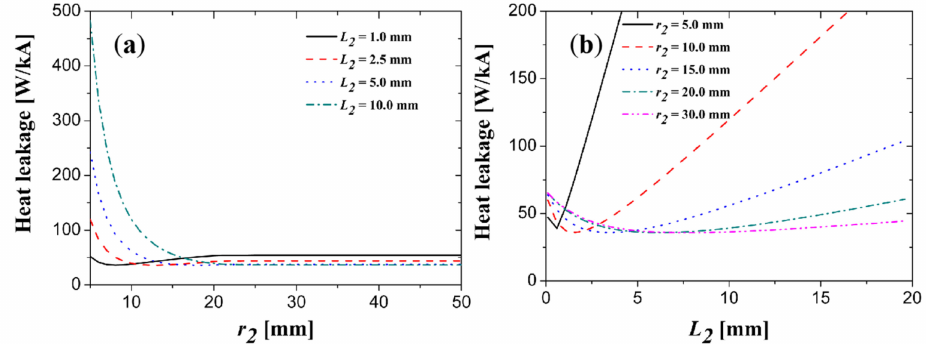
Figure A13. Iteration step one: the coupling influence between D ( r 2 ) and E ( L 2 ) on the cold end heat leakage of PCLs (keeping parameters r 1 = 20.0 mm, L 1 = 100.0 mm, L 3 = 1500.0 mm unchanged; in this iteration Q min = 35.7 W/kA). ( a ) The heat leakage vary with D ( r 2 ); ( b )The heat leakage vary with E ( L 2